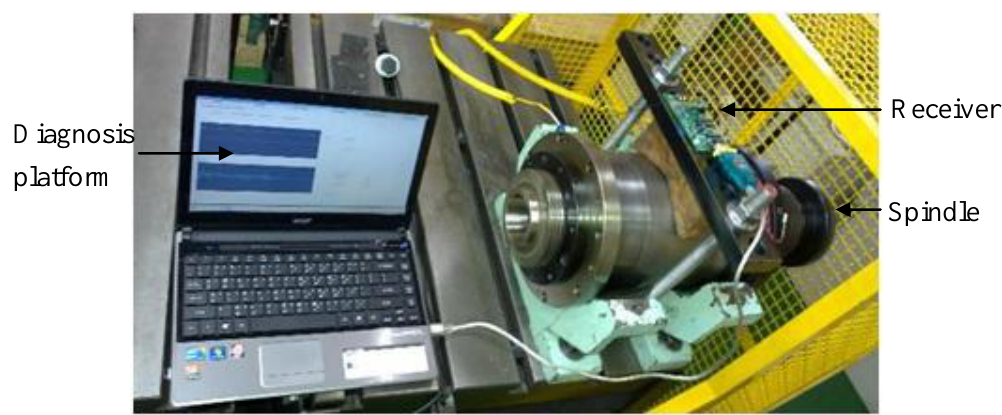
Figure 5. The testing platform of the